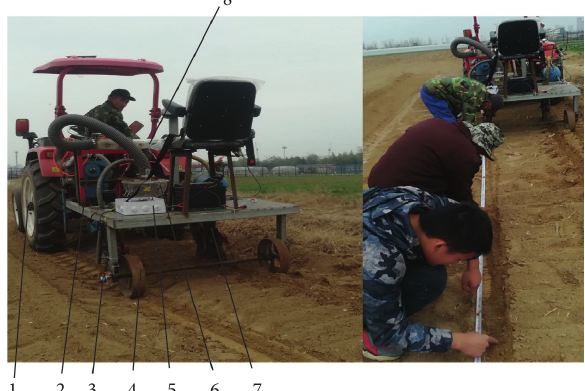
Figure 11: Field trial. (1) Tractor. (2) Vacuum fan. (3) Encoder. (4) Land wheel. (5) Control System. (6) Waste seed storage room. (7) Combined air suction seed meter. (8) Three-way switching